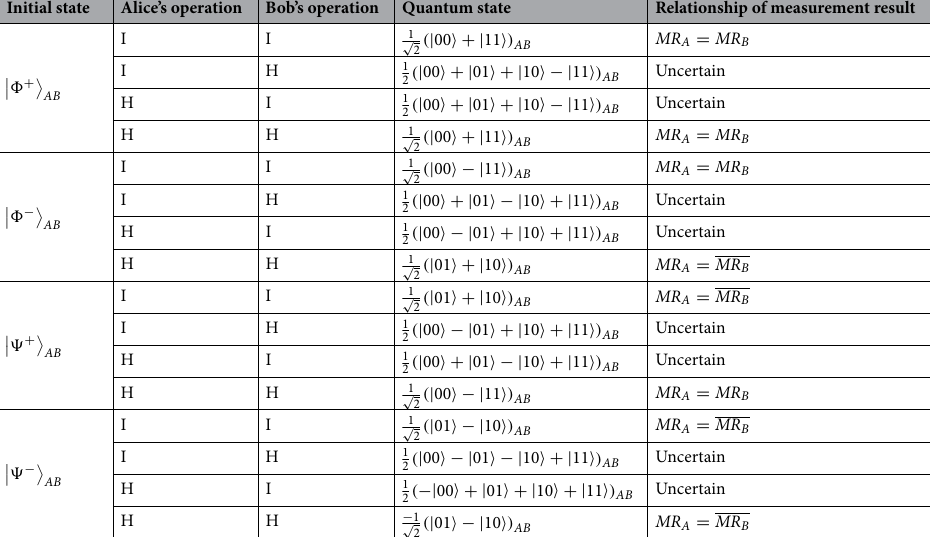
Table 1. Relationship between measurement results and unitary